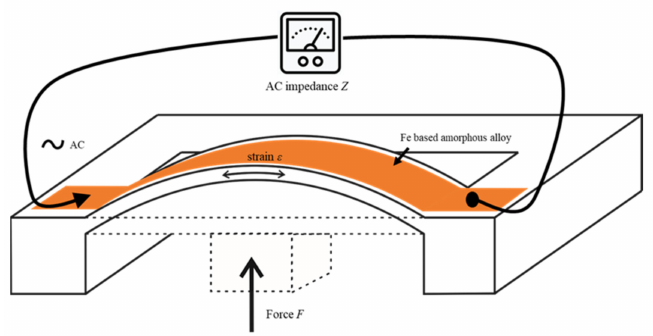
Figure 3. Basic structure and principle of the SI force sensor: an incoming force strains a layer of FeCuNbSiB soft magnetic alloy, which is deposited on a cantilever. The resulting change in AC impedance is measured.